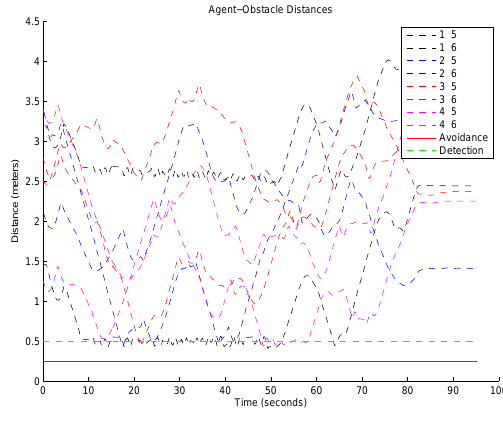
Fig. 18. Robot-obstacle pair distances of Experiment